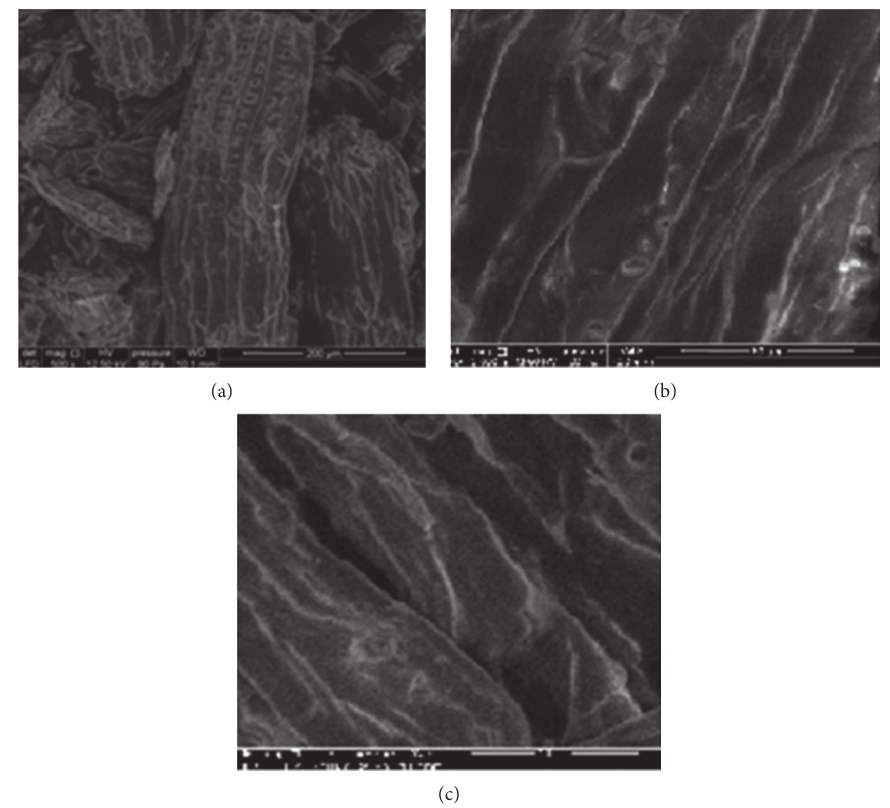
Figure 3: SEM images: (a) raw-A, (b) A-HCl, and (c) A-NaOH.